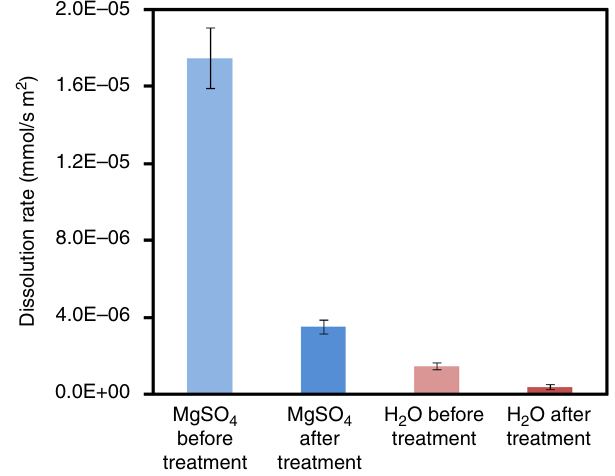
Fig. 8 Dissolution rate of untreated and bio-treated calcite in 1 M MgSO 4 and H 2 O. Error bars show s.d. ( ± 1 σ